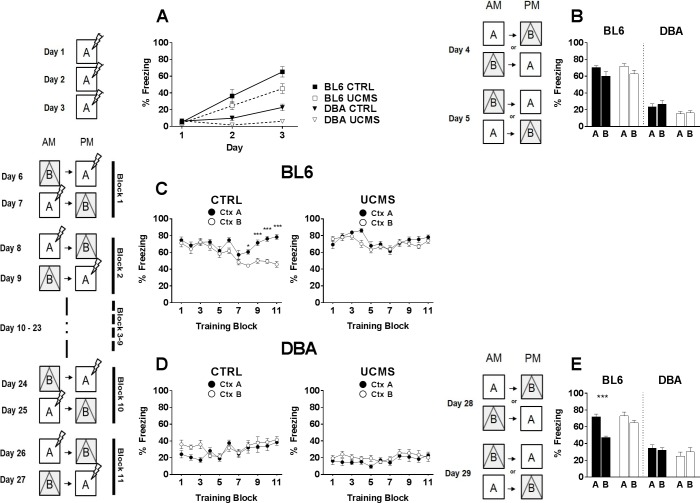
Contextual discrimination threat conditioning.(A) During context acquisition conditioning, mice exposed to UCMS showed less freezing behavior over time when compared to non-exposed controls. (B) Equivalent freezing behavior between UCMS-exposed and control groups was observed during generalization tests. (C) During context discrimination training, BL6 CTRL mice learned to distinguish context A from context B, whereas UCMS exposed mice did not. (D) DBA mice overall showed little freezing behavior and failed to distinguish context A from B, regardless of UCMS exposure. (E) A second generalization test revealed increased contextual discrimination behavior in unexposed BL6 controls. Values are expressed as mean +/- SEM. *, p < 0.05; ** p < 0.01; *** p < 0.001.